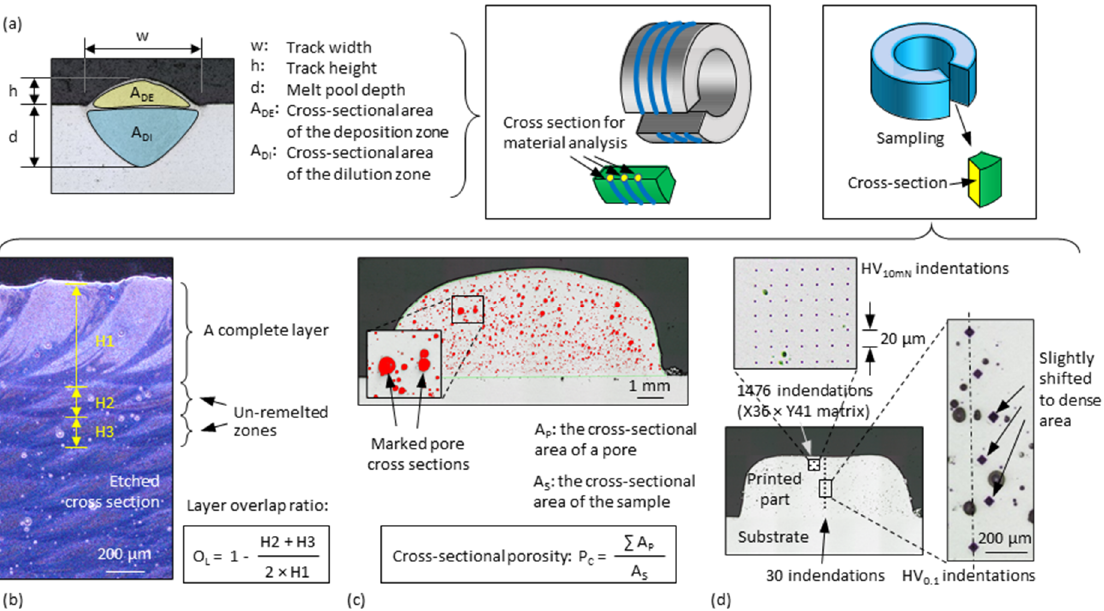
Figure 7. Schematic illustrations of the different material analyses: ( a ) dimension measurement of the cross-section of a single track (indicated by the blue lines); ( b ) measurement of layer overlap ratio of a 3D-part; ( c ) measurement of the cross-sectional porosity of a 3D-part; ( d ) hardness measurement by micro- and nanoindentation of a 3D-part.